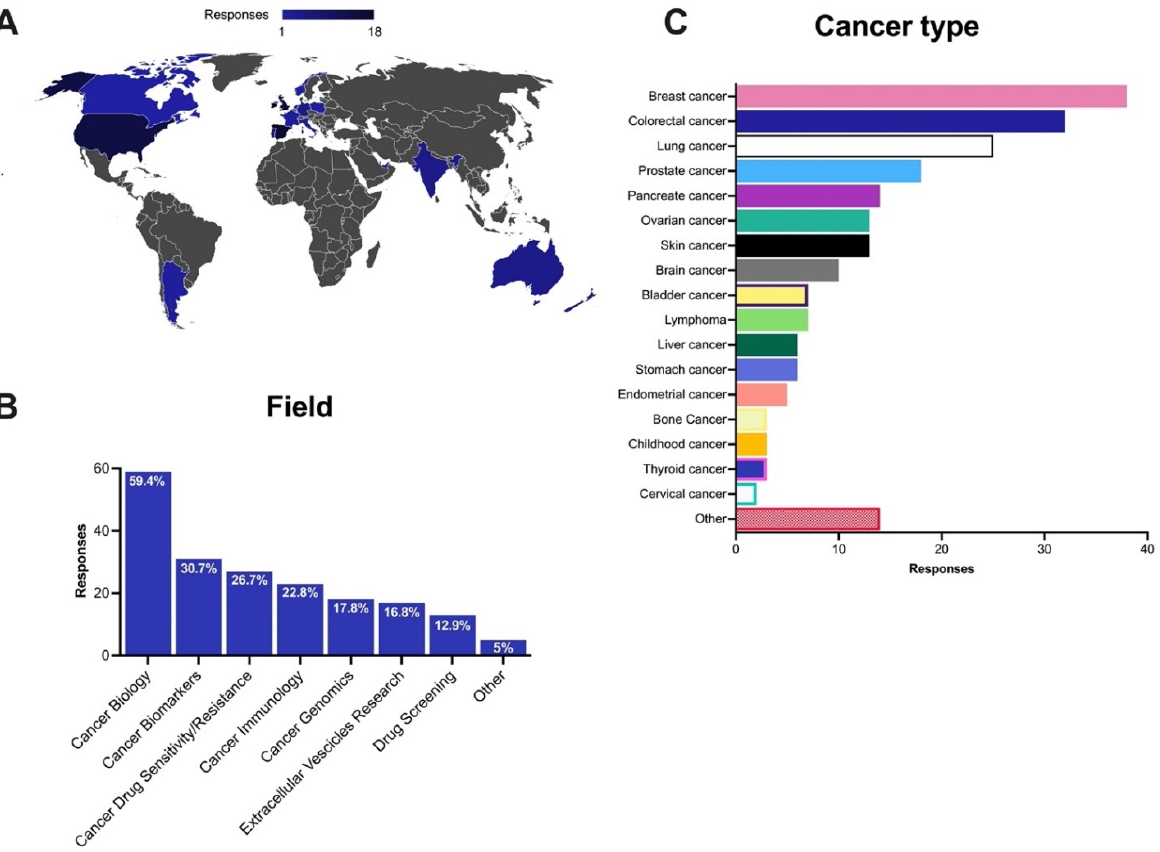
Figure 2. General profile of the respondents. ( A ) Number of respondents categorized by the country of work. The graph was obtained from 101 responses; ( B ) Field of cancer research performed; ( C ) Cancer type studied by the respondents. Note: some respondents indicated that they are involved in more than one field of research and/or work on more than one cancer type.